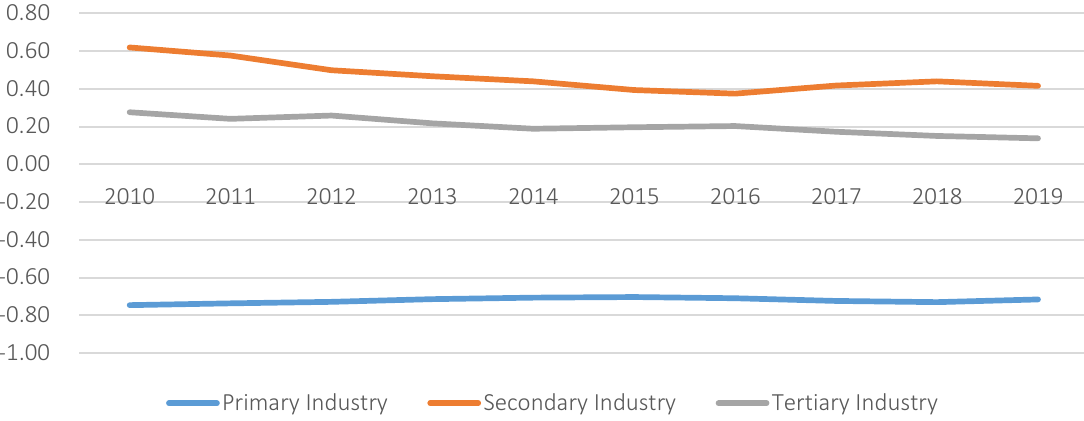
Figure 5. Trend chart of deviation coefficient of the employment structure in various industries in China